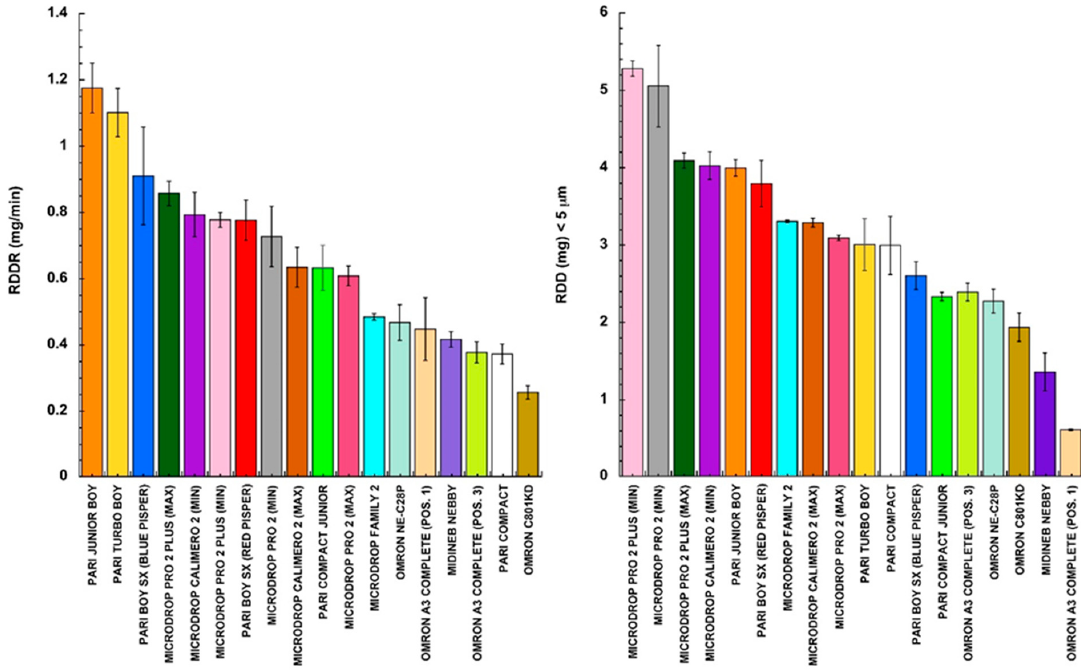
Figure 4. Respirable dose delivery rate (RDDR) and the total respirable delivered dose (RDD) ranked accordingly to the nebulizer used (mean value ± standard deviation, n = 3).